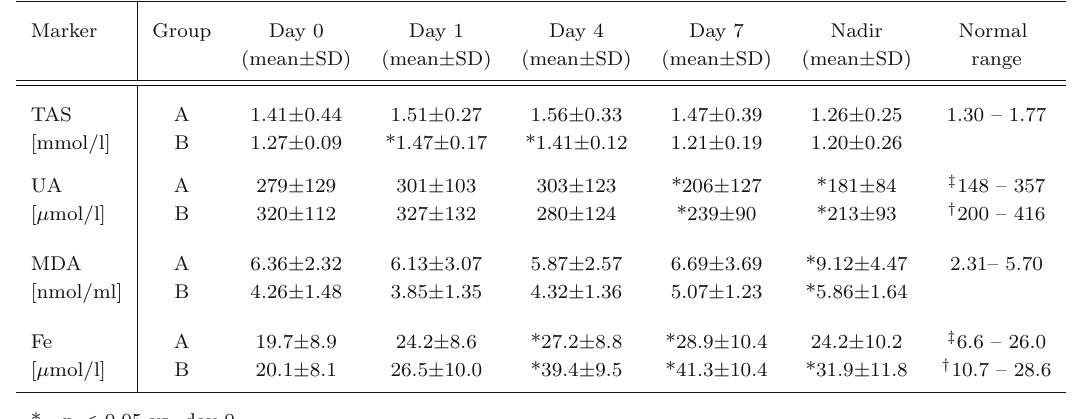
Table 3 Changes in blood antioxidant/prooxidant markers in the course of conventional chemotherapy of AML patients in the acute phase of the disease (group A, n = 12) and of AML patients in complete remission (group B, n = 7).